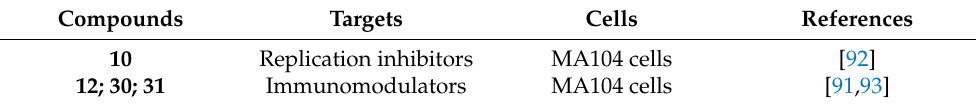
Table 7. Summary of anti-RV triterpenoids and their targets and